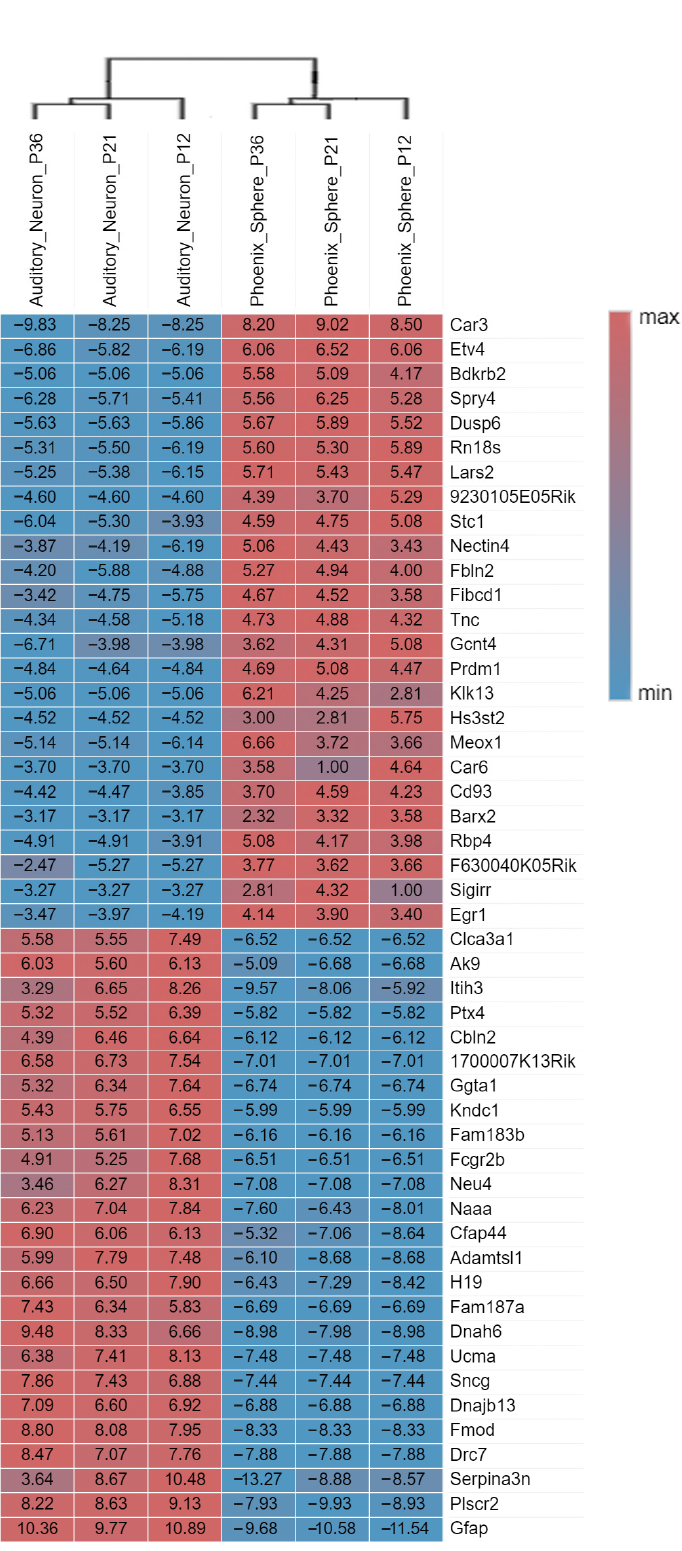
Figure 3. Heatmap of the top 25 up- and down-regulated phoenix sphere DEGs with the highest fold change. The fold change value of each gene is shown in boxes. Red and positive values indicate the fold change of up-regulation while blue and negative values stand for down-regulation. The hierarchical clustering analysis further proves the samples are keeping consistent quality within the group. Each gene’s ‘fold change’ is calculated by comparing a target gene count to the average gene count of the